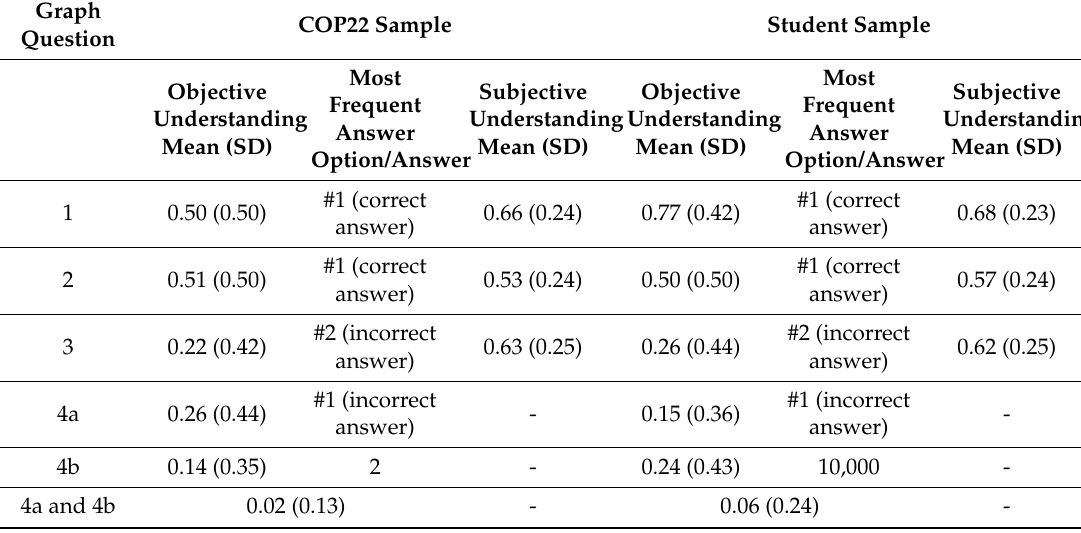
Table 2. Objective and subjective understanding of the health chapter graphs in the COP22 and the student